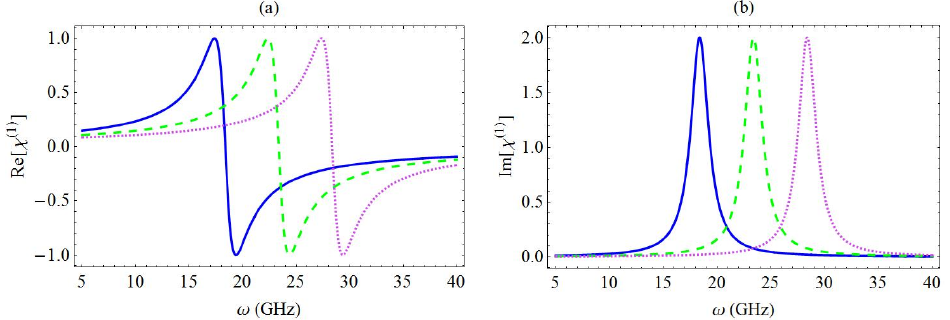
(1) χ for different values of the